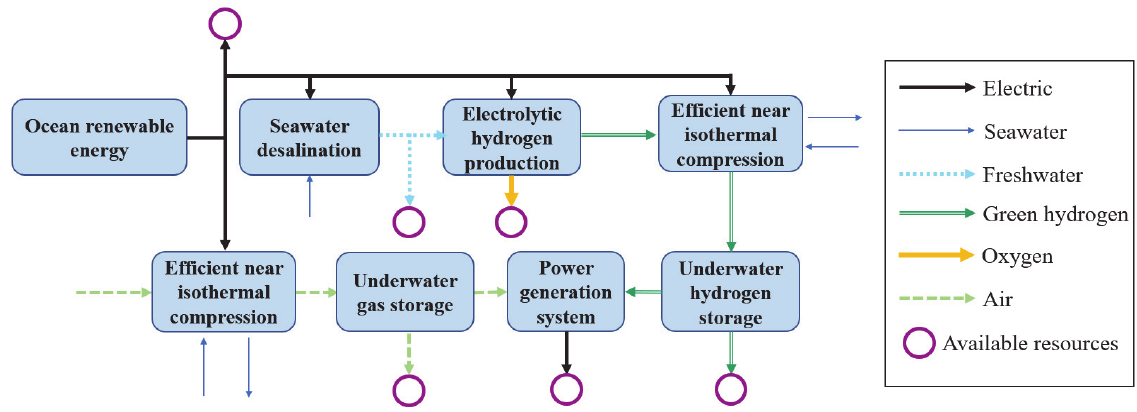
Figure 7. An integrated application mode of UWCGES.